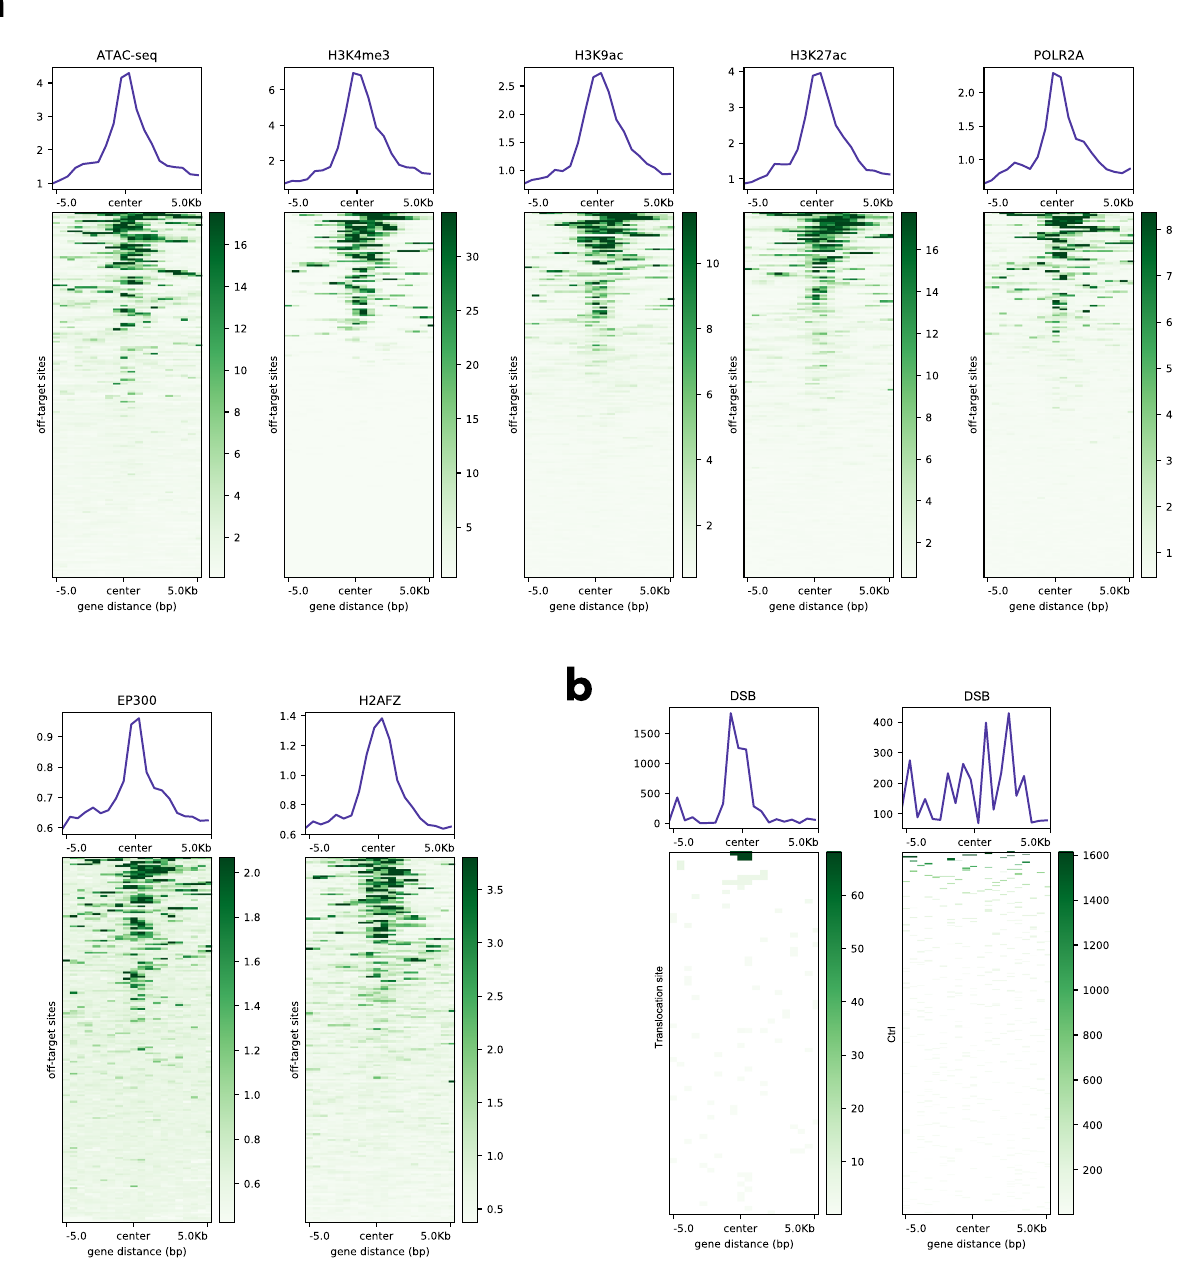
Fig. 6 | The genomic context of PEAC-seq off-target and translocations. a Signals of the ATAC-seq peaks and ChIP-seq peaks of multiple histone mod- i fi cations and proteins surrounding the PEAC-seq off-targets. b Signals of the DSB